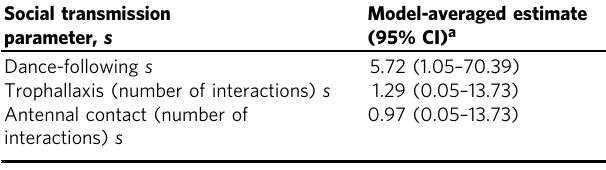
Table 5 Estimated rates of social transmission ( s ) in the FULL feeder reactivation